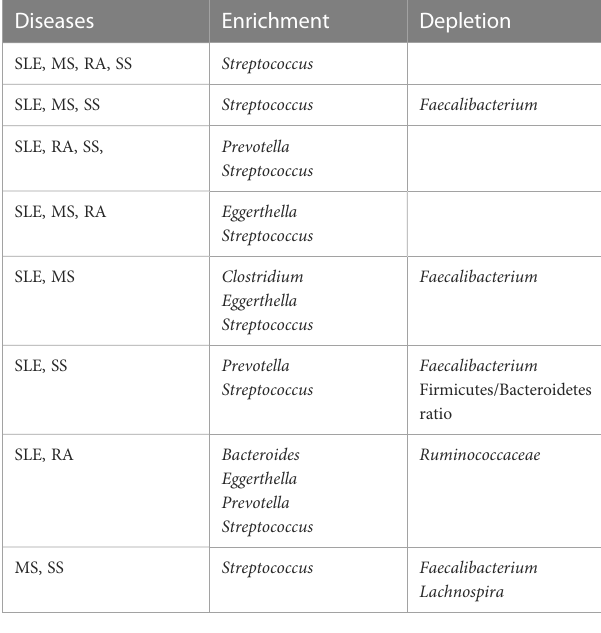
TABLE 2 Altered gut bacteria shared in different autoimmune diseases.